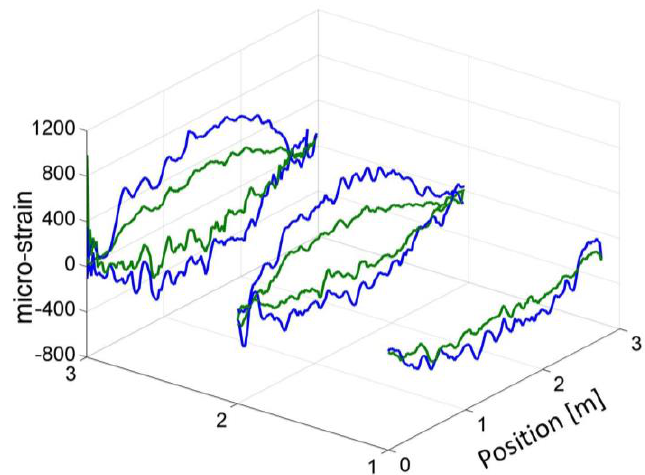
Figure 6. Strain variations due to the loading of a composite model wing of an unmanned aerial vehicle, measured using phase-coded B-OCDA. Five sensing fibers that were embedded in the outer skin of the model during production: two in the upper surface and three in the lower surface. Green and blue traces correspond to static loading of 275 N and 550 N, respectively.